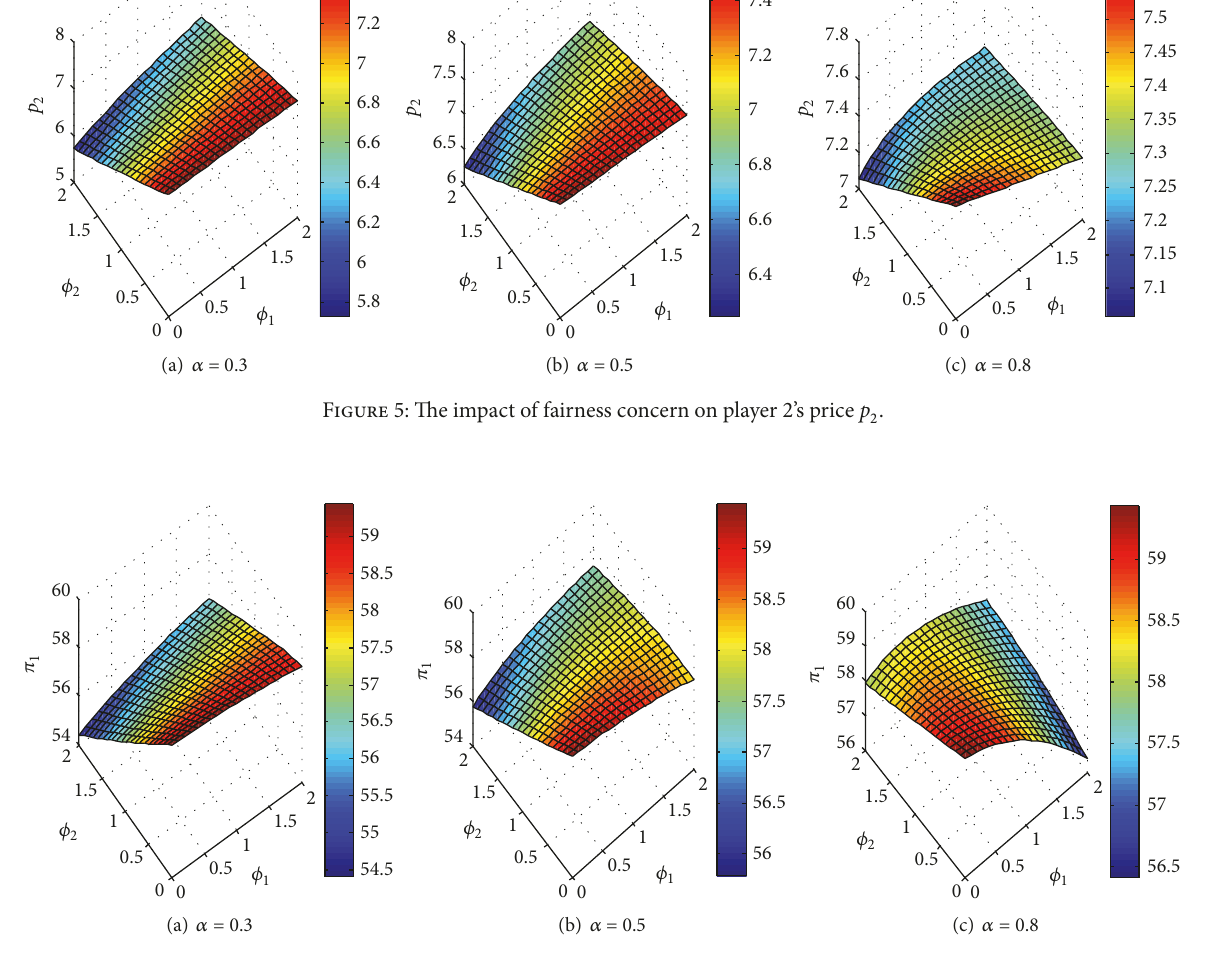
Figure 6: The impact of fairness concern on player 1’s expected profit 𝜋 1 .